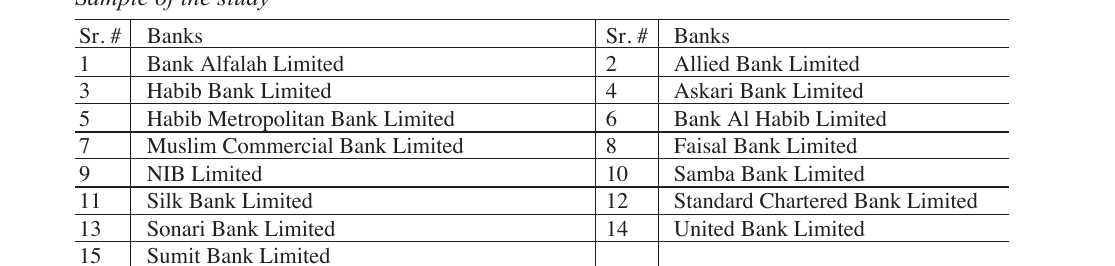
Sample of the study